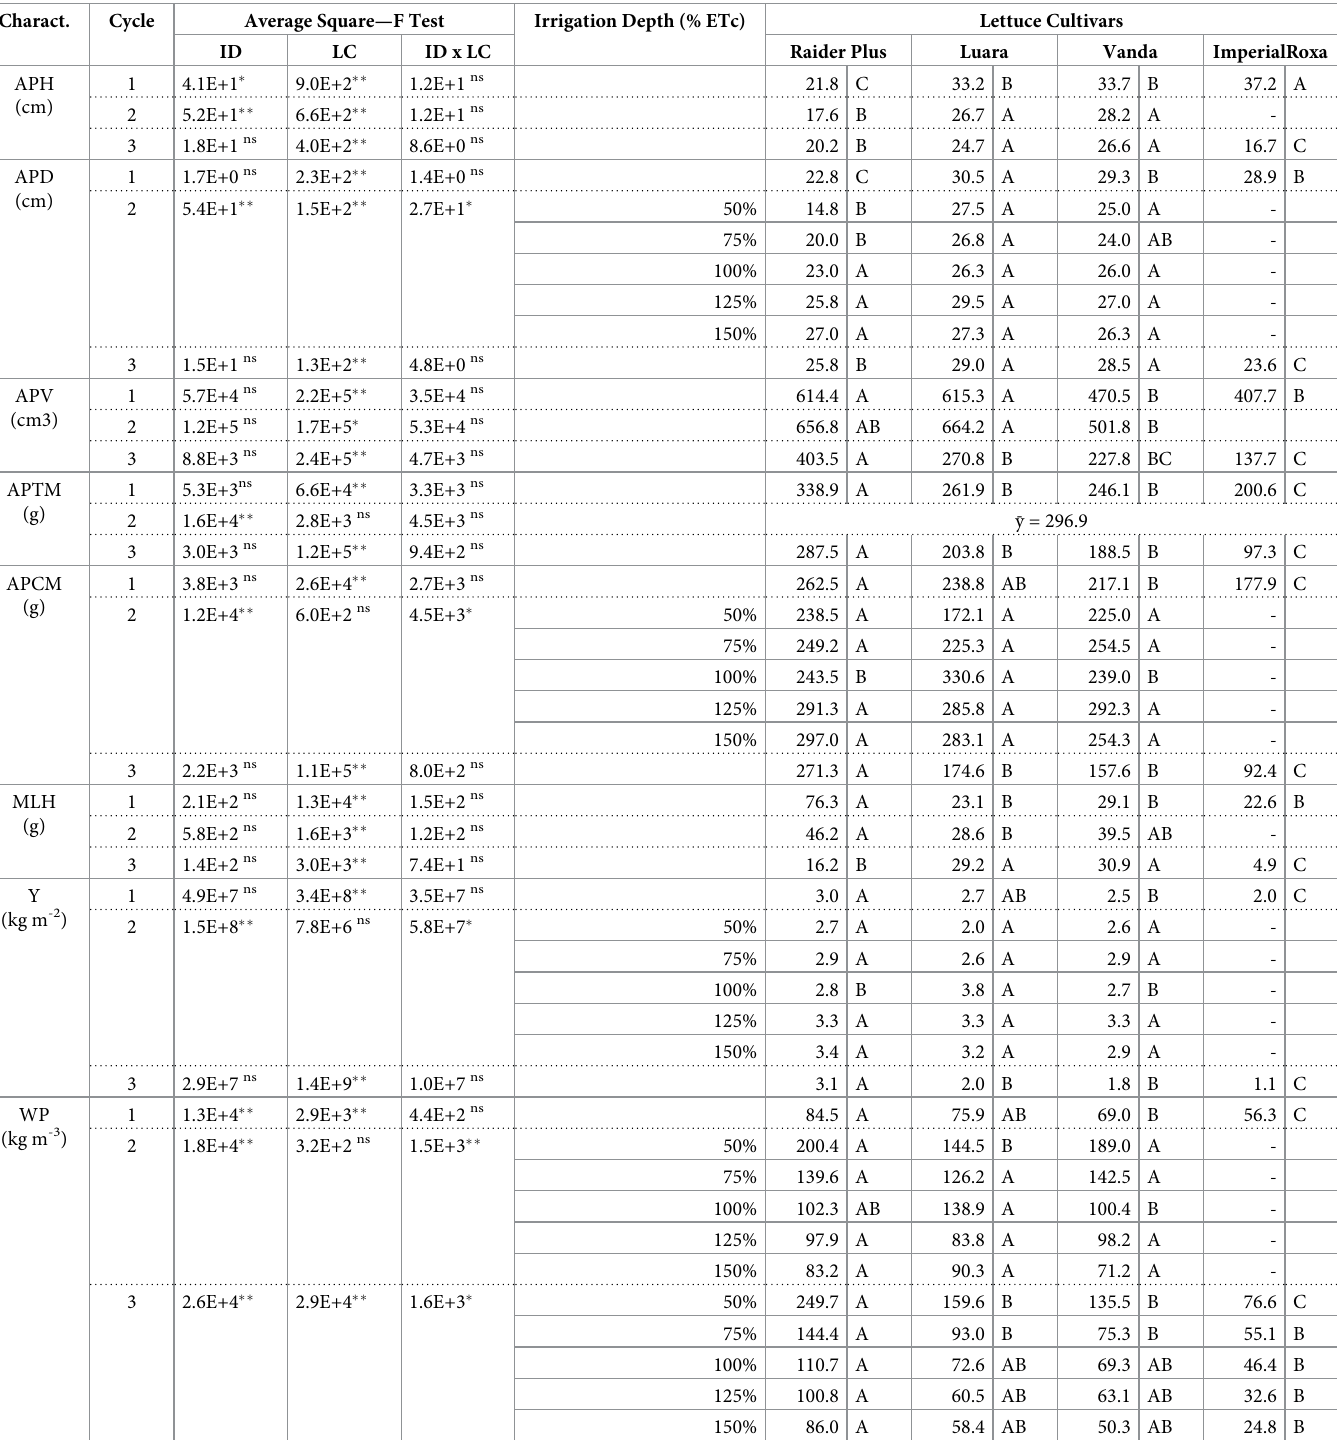
Table 5. Average square significance of the F test (ANOVA) and average values for aerial part characteristics: aerial part height (APH), diameter (APD) and volume (APV), aerial part total mass (APTM) and commercial mass (APCM), mass of aerial part loss at harvest (MLH), crop yield (Y) and water productivity (WP) as a function of different cultivars and irrigation depths in three lettuce crop cycles.